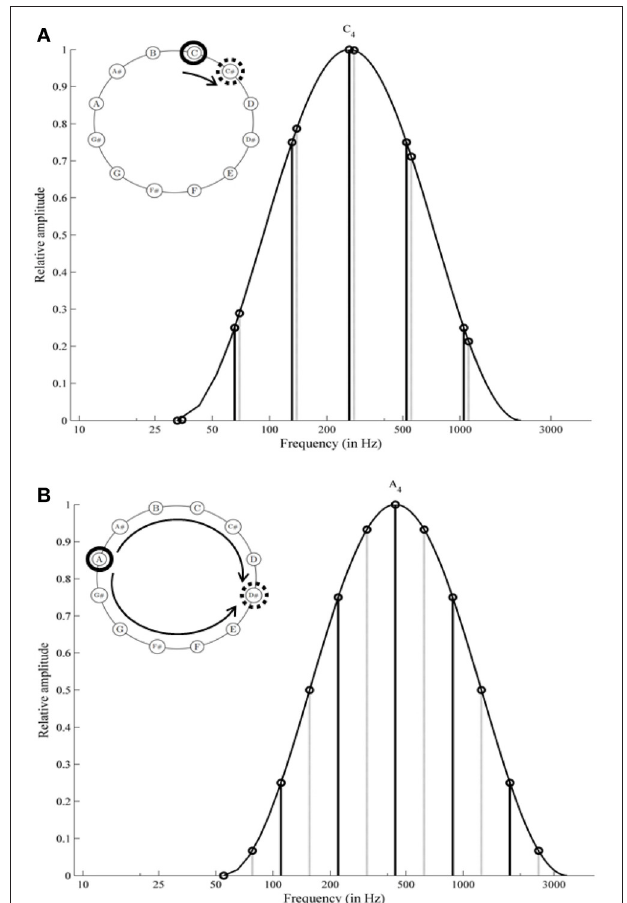
FIGURE 1 | Spectral structure of Shepard tones: C and C # are generated under an envelope centered at C 4 (261.63 Hz); the components of C # are shifted 1 semitone from components of C ; the distance on the pitch class circle is shorter clockwise than counterclockwise; the frequency shift to the right is shorter than to the left (A) ; A and D # are generated under an envelope centered at A 4 (440 Hz); the components of D # are shifted 6 semitones from components of A ; the distance on the pitch class circle is equal clockwise and counterclockwise (tritone interval, B ). The envelope centered at A 4 (B) is slightly shifted to the right in comparison with the envelope centered at C 4 (A) . The relation of component amplitudes of C under C 4 is the same as the relation of component amplitudes of A under A 4